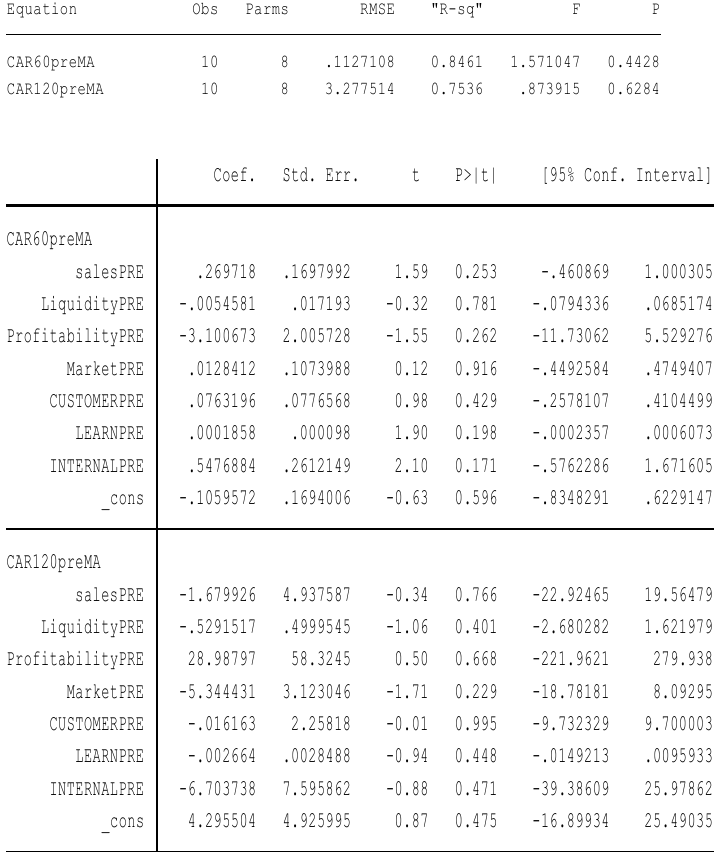
Table F1. Testing the relationship between BSC perspectives and CAR 60&120 pre-M&A